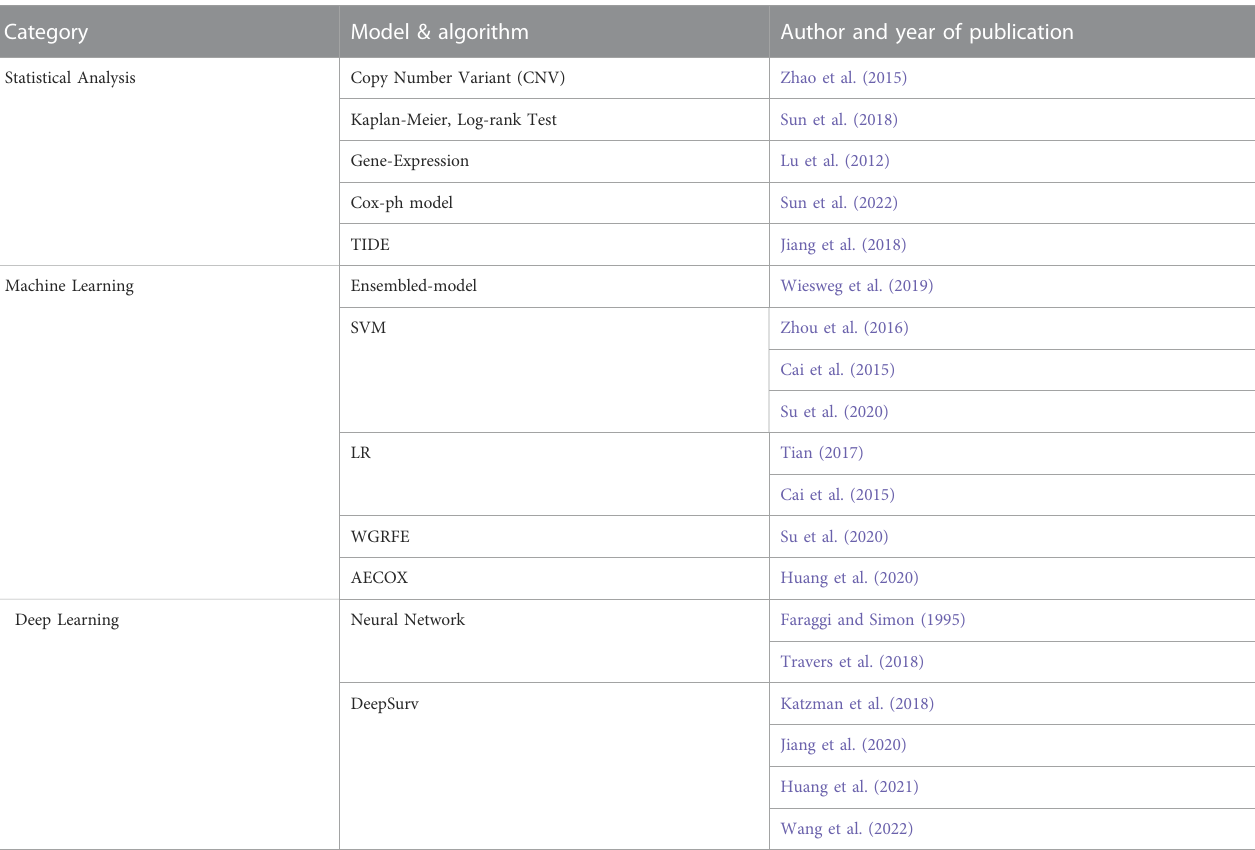
TABLE 2 Analysis methodology identi fi ed by AI technique. The statistical part includes analysis using simple mathematical models including test techniques and regression represented by the Cox-ph model. AI techniquesusing big data canbe divided into machine learning and deep learning. In the machinelearning part,SVM ismainlyused,andtheensembledmodelwithDecisionTreeaddedisalsoincreasinginfrequencyrecently.IntheDeepLearningpart,researchisactivelyunderwayby adding neural networks to various models.